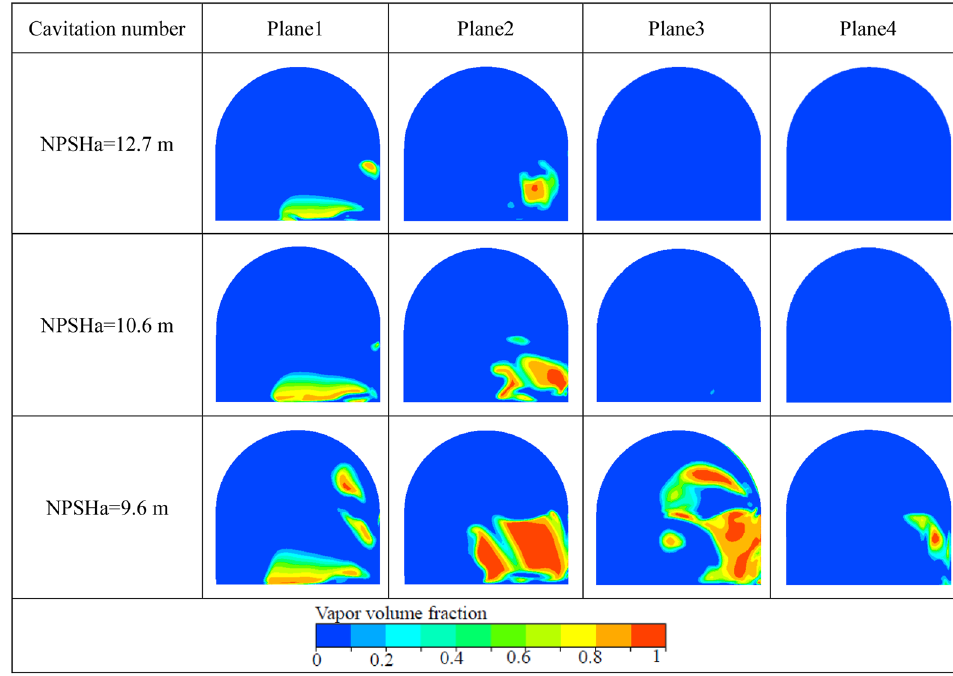
Figure 11 Contour of vapor volume fraction at a typical instant ( t